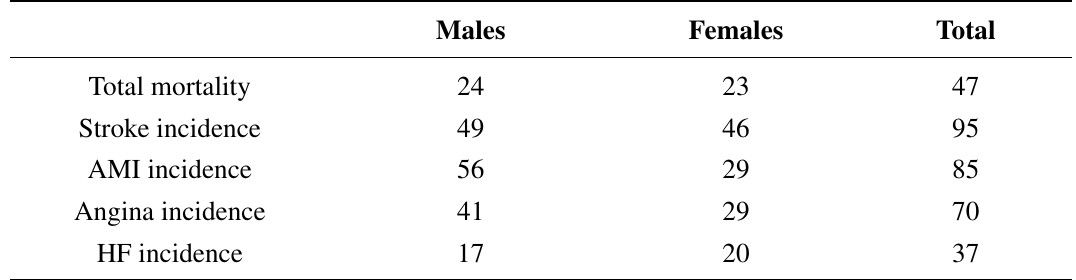
Table 1. Estimate of potentially avertable mortality and morbidity incidence cases in the 2011 Dutch population cohort aged ě 20 years, if reducing sodium in soups by 25%.